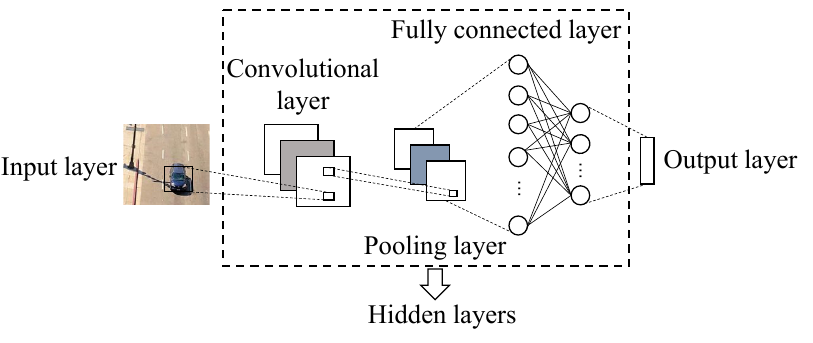
Figure 6. Typical CNN architecture.